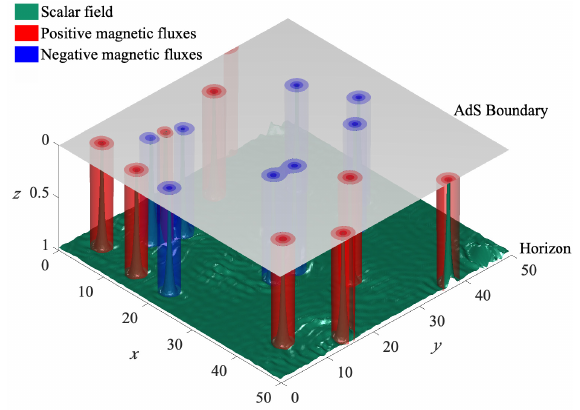
Figure 1. Typical configurations of matter fields in the bulk at the final equilibrium state (the average order parameter arrives at a plateau) after quench. Green color is the isosurface of scalar field while red (blue) color represents positive (negative) magnetic fluxoids. Order parameter vor- tices are confined in the magnetic fluxoids, indicating a type-II superconductor